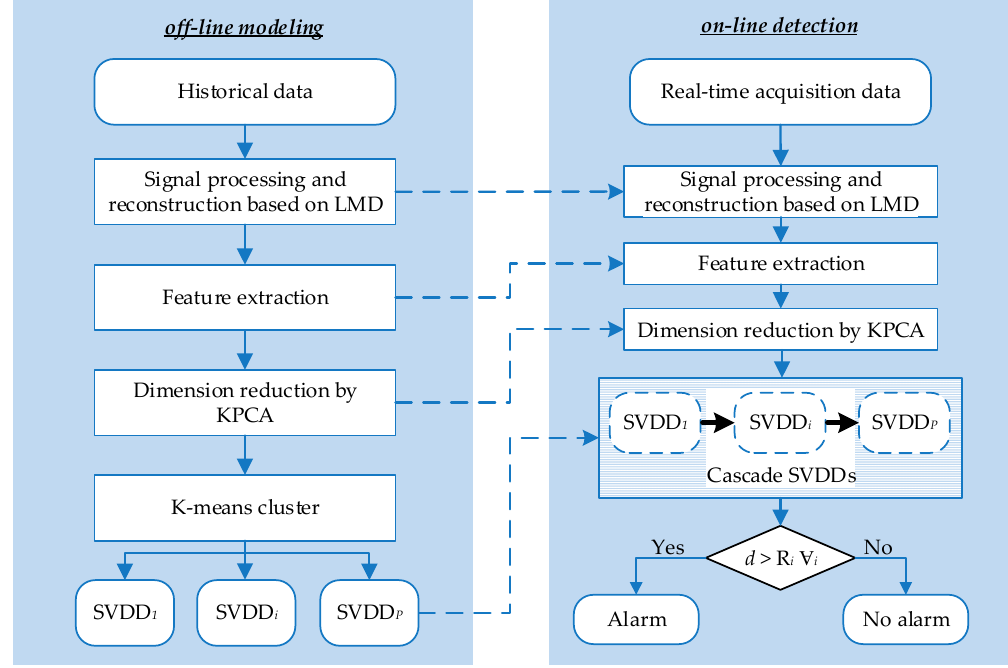
Figure 2. Flowchart of the proposed method.